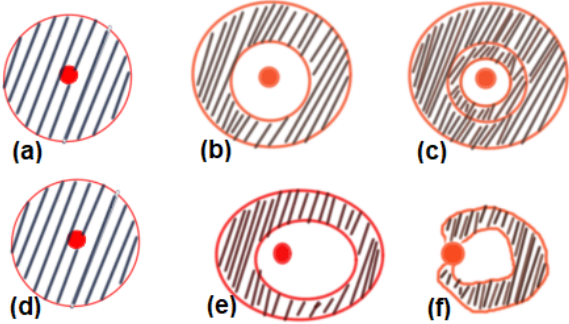
Figure 1. Schematic representation of chemical tracer method in a single well test involving injection of tracer ( a – c ) without drift and ( d – f ) with